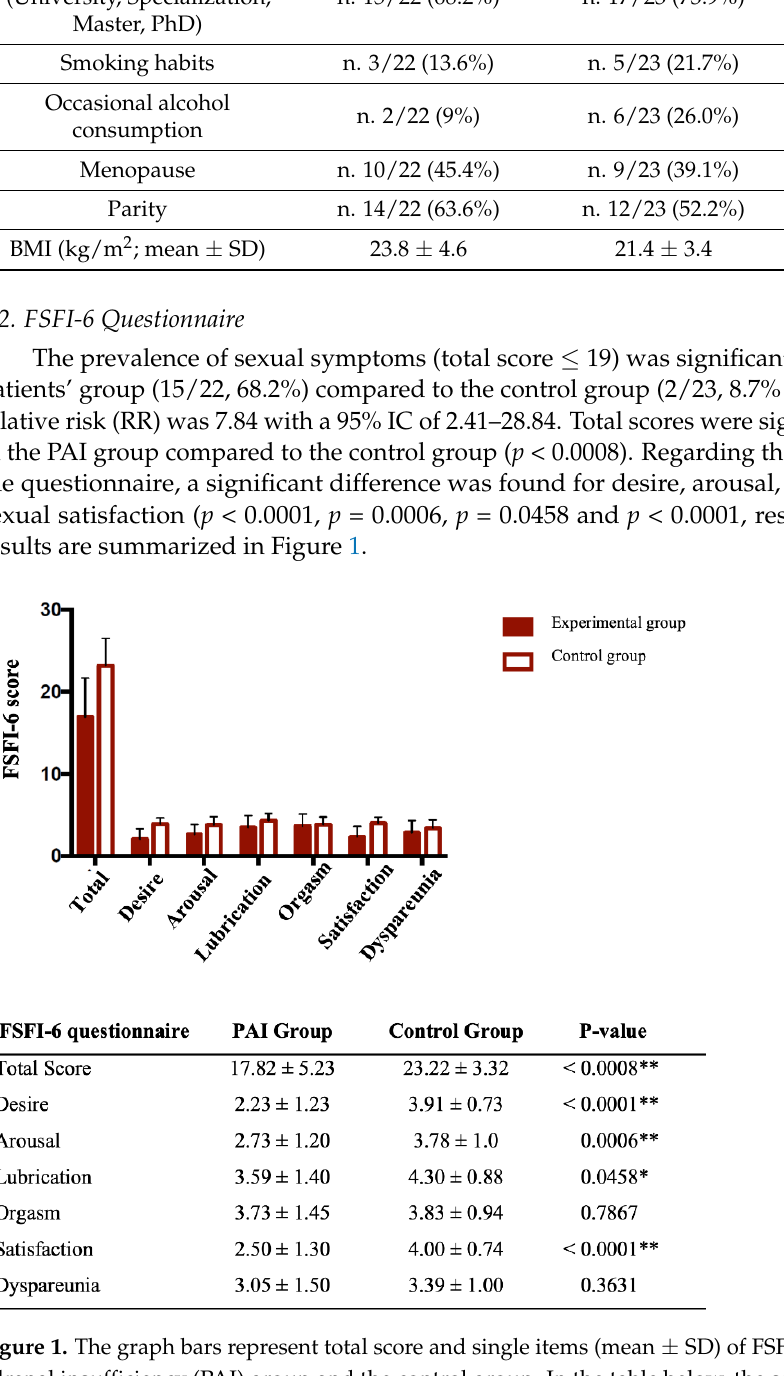
Figure 2. Correlation between FSFI-6 total score and serum cortisol levels in patients ’ group (Spear- man correlation test; p = 0.03; r = 0.55). 3.3. Sexual Distress Questionnaire (SDS) The prevalence of SD (total score > 15) was significantly higher in the PAI (10/22, 45.5%) compared to the control group (2/23, 8.7% p = 0.007). The relative risk (RR) was 5.22, with a 95% IC of 1.51 – 19.90. The prevalence of SD in patients affected by PAI with a of FSFI score < 19 was 60% (9/15). A significant inverse correlation was found between SDS total scores and FSFI-6 total scores (Pearson correlation analysis r = − 0.6482, IC 95%: − 0.8402 to − 0.3118; p = 0.0011) (Figure 3).